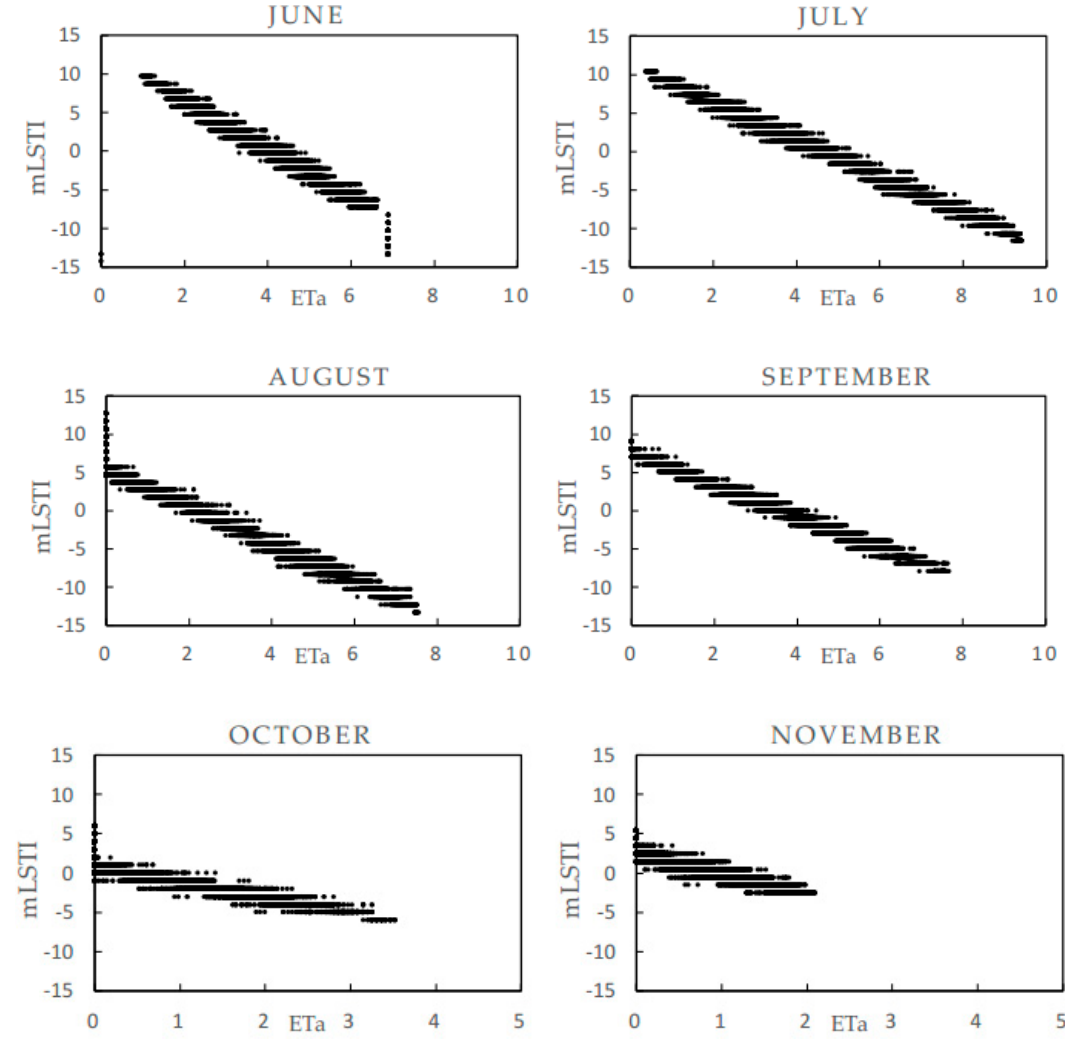
Figure 10. Scatter plots of ETa and mLSTI.